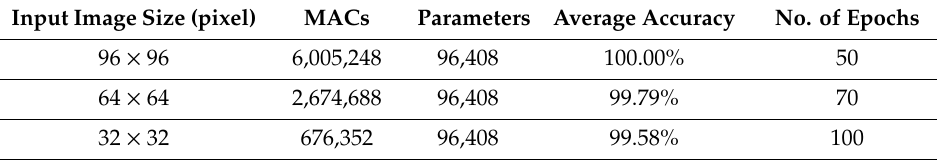
Table 4. Results of training proposed model with various image